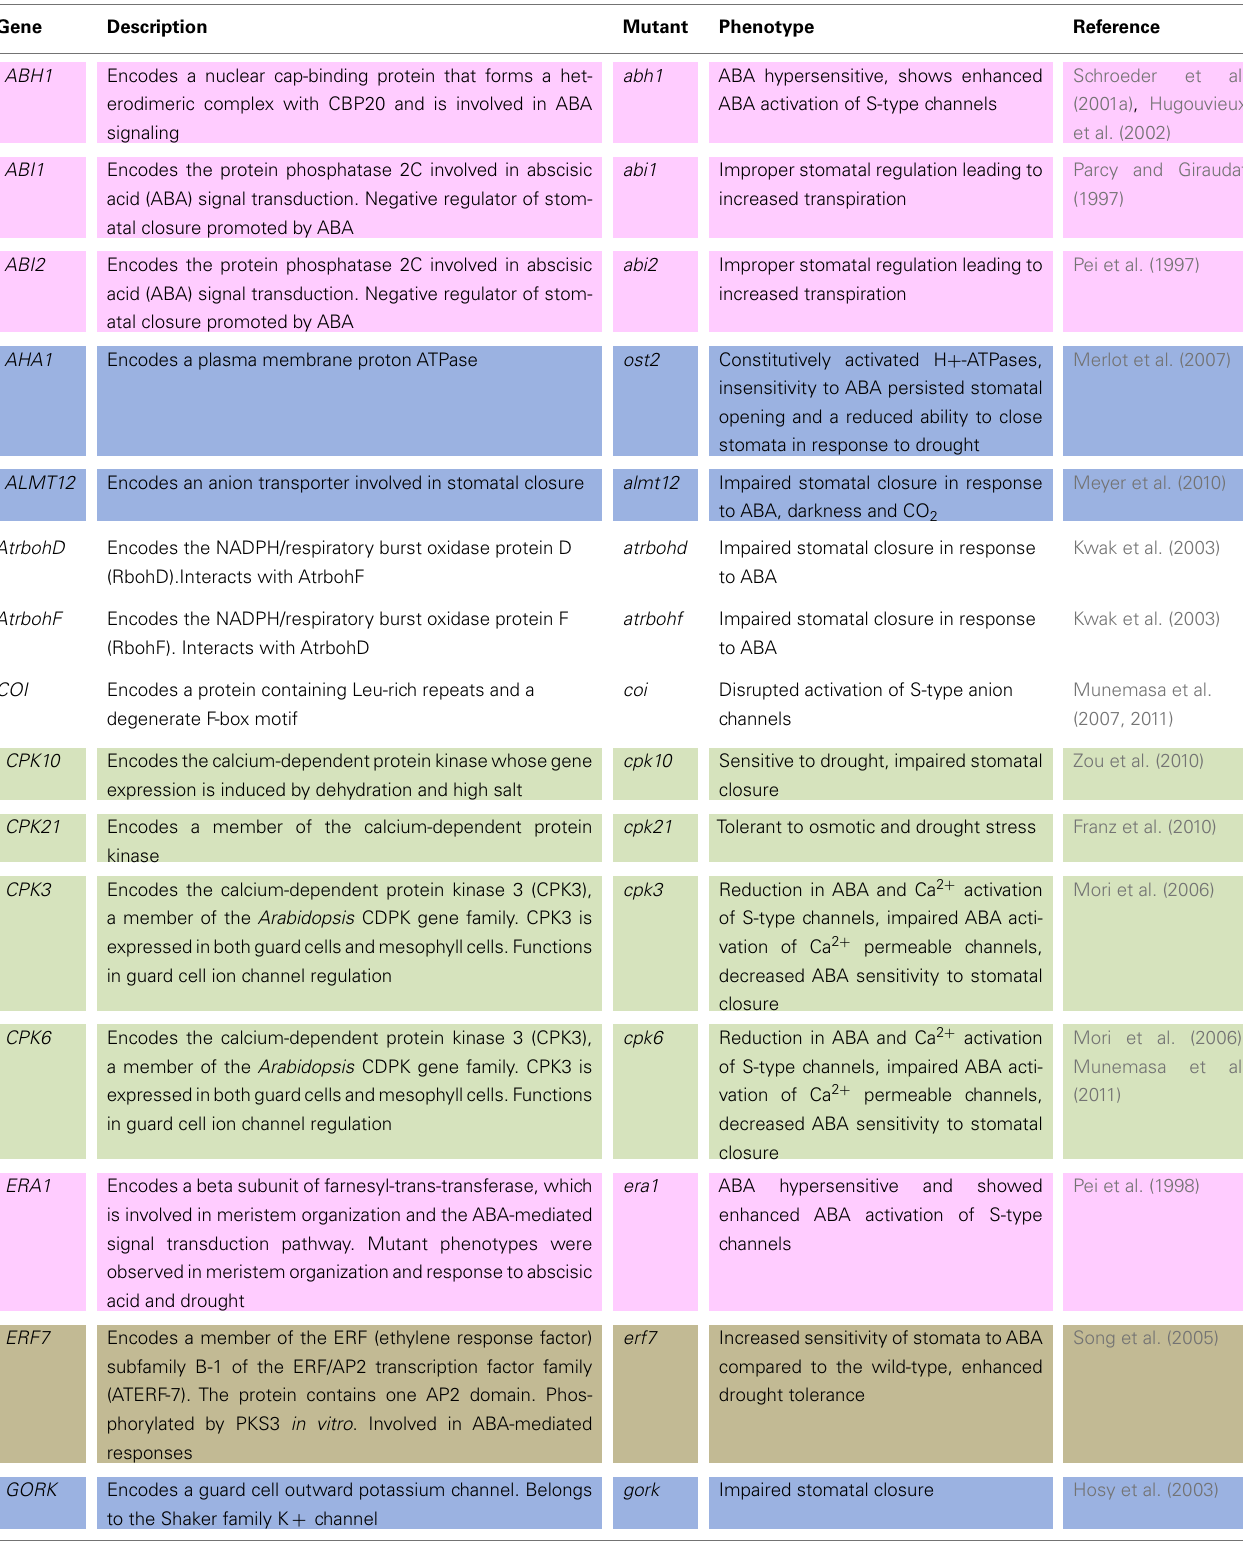
Table 1 | Selected genes involved in the regulation of stomatal movement under